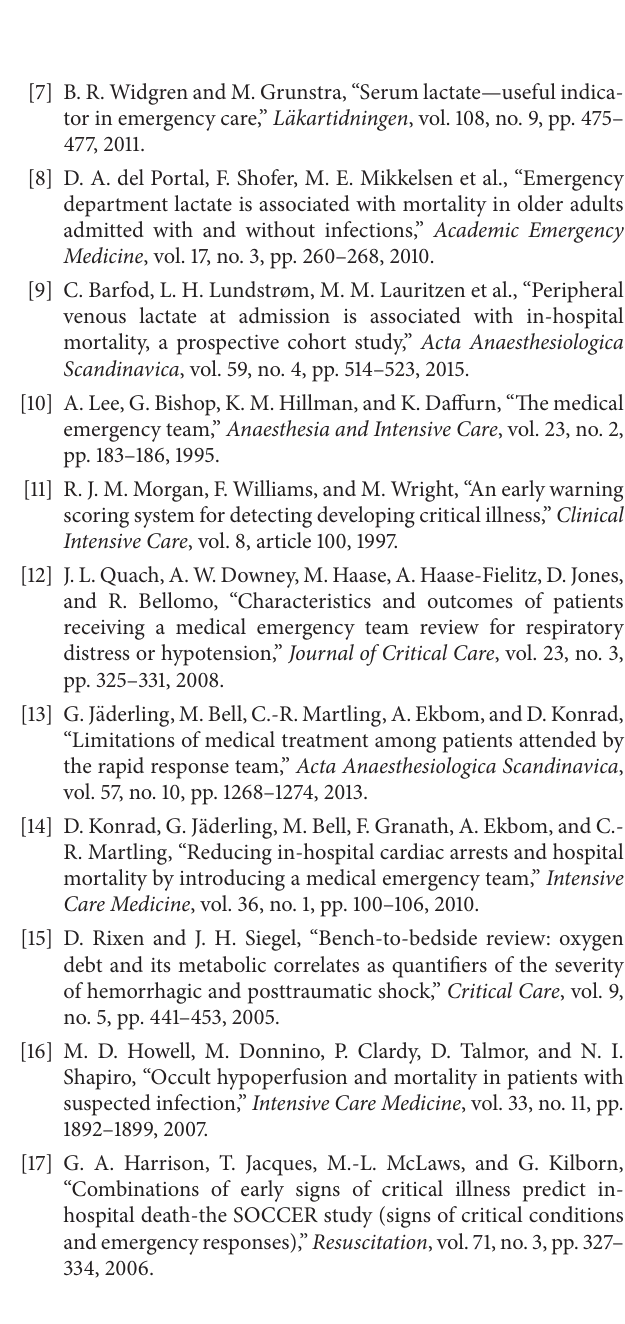
PPV, positive predictive value. NPV, negative predictive value.